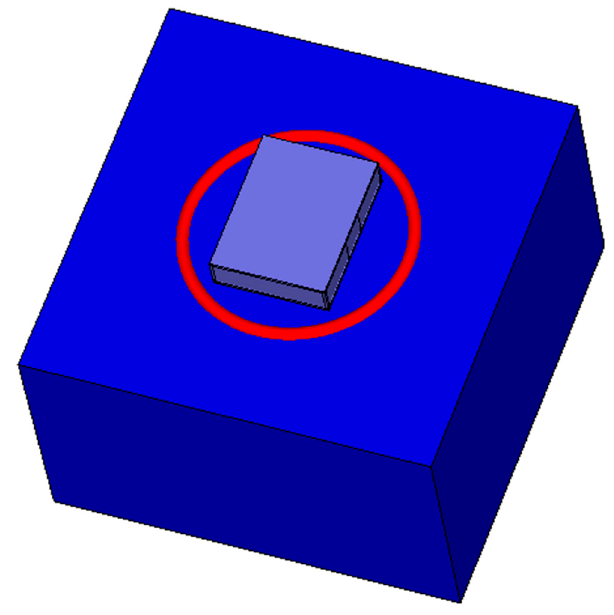
Figure 8. Braid antenna enclosed in PLA container on a plastic foam buoy floating on water surface.